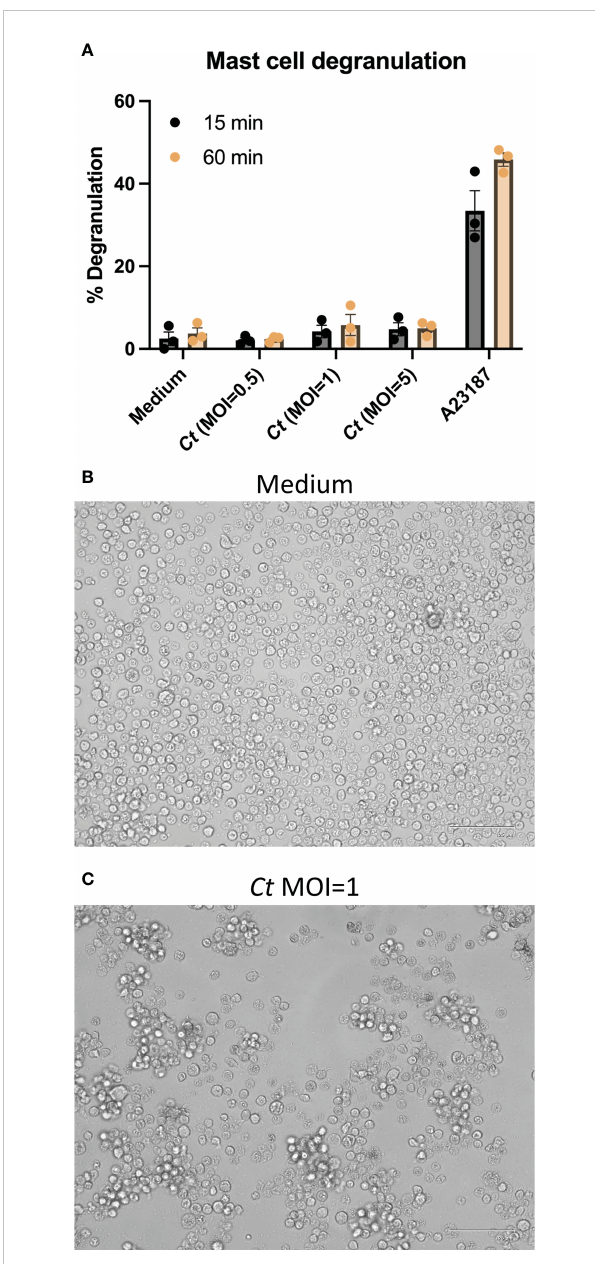
FIGURE 2 Human mast cells do not undergo degranulation but exhibit cellular activation with homotypic aggregation. (A) CBMCs were incubated with C trachomatis MOI = 0.5, 1, and 5, A23187 (calcium ionophore), or medium alone for 15 or 60 min. b -hexosaminidase released into culture supernatants was measured relative to b -hexosaminidase in cell pellets. Data are presented as the mean % degranulation ± SEM. The data represent two independent experiments with n = 3 donors (B , C) . CBMCs were treated with C trachomatis MOI = 1 for 24 h and images of C trachomatis -treated cells (C) and paired medium controls (B) were acquired under an inverted phase-contrast microscope. Images are representative of two independent experiments with n = 3